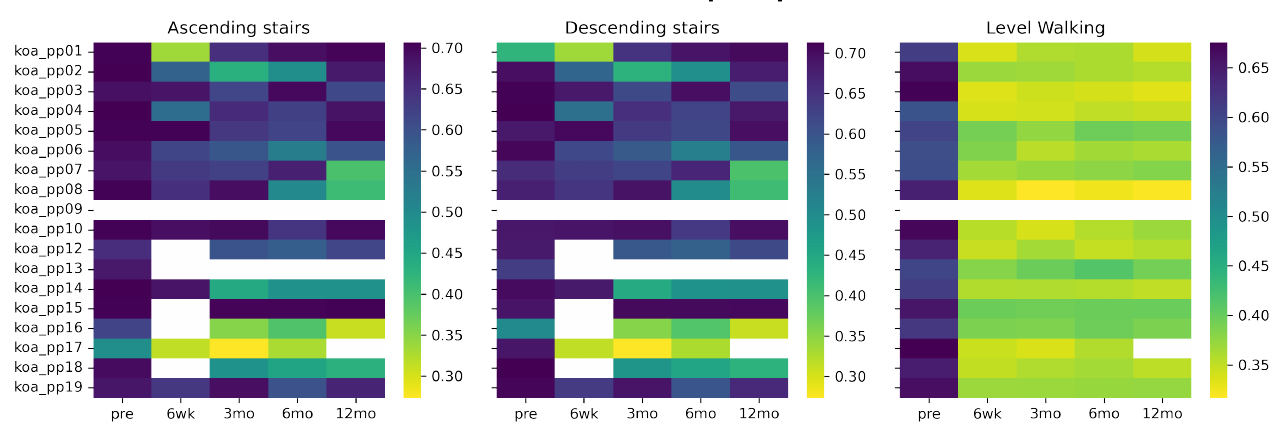
Figure 1. Heatmap of the probability of belonging to the patient class for each individual (subject identifiers are on the y-axis). Darker colours indicate a high probability of belonging to the TKA class, and the lighter the colours lower the probability. The model was developed on pre-operative data of either ascending stairs, descending stairs, or level walking.